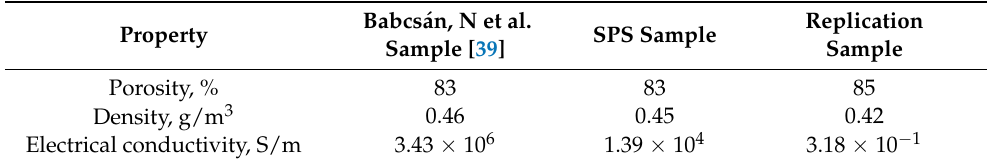
Table 6. Properties comparison of open-cell aluminum